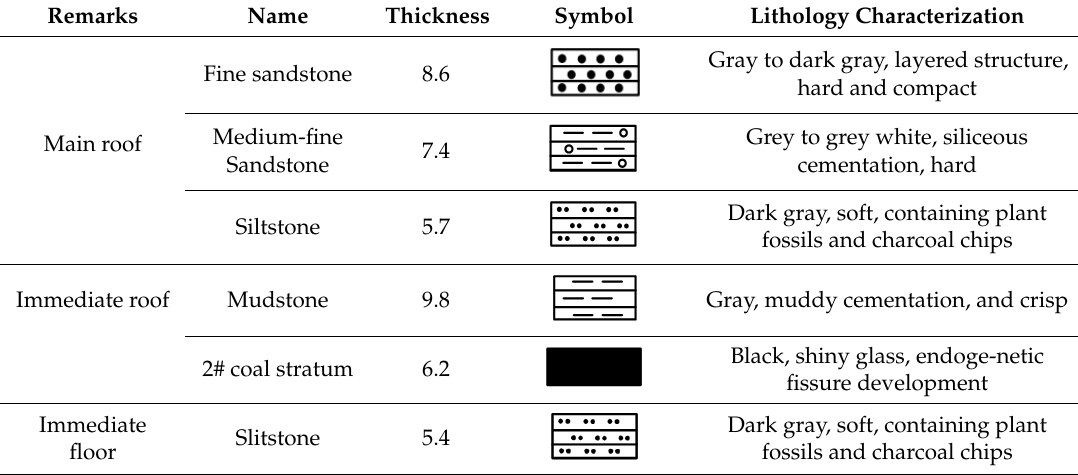
Table 1. Stratigraphic description of the 2106 coal face.